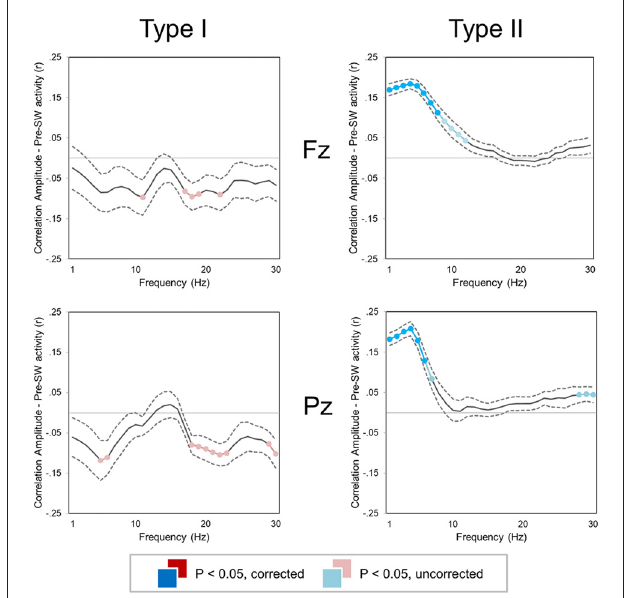
FIGURE 5 | Correlation between slow wave amplitude and background EEG activity ( ± SE, dashed lines) for two small regions of interest (ROIs) centered on Fz (top) and Pz (bottom). Colored (red, cyan) sections indicate significant correlations (Bonferroni corrected p < 0.05; lighter colors indicate uncorrected p < 0.05). For both type I (left column) and type II (right column) slow waves, the mean power was computed in 1 Hz frequency bins for the time window corresponding to − 2.5 to − 0.5 s with respect to the first zero-crossing of the slow